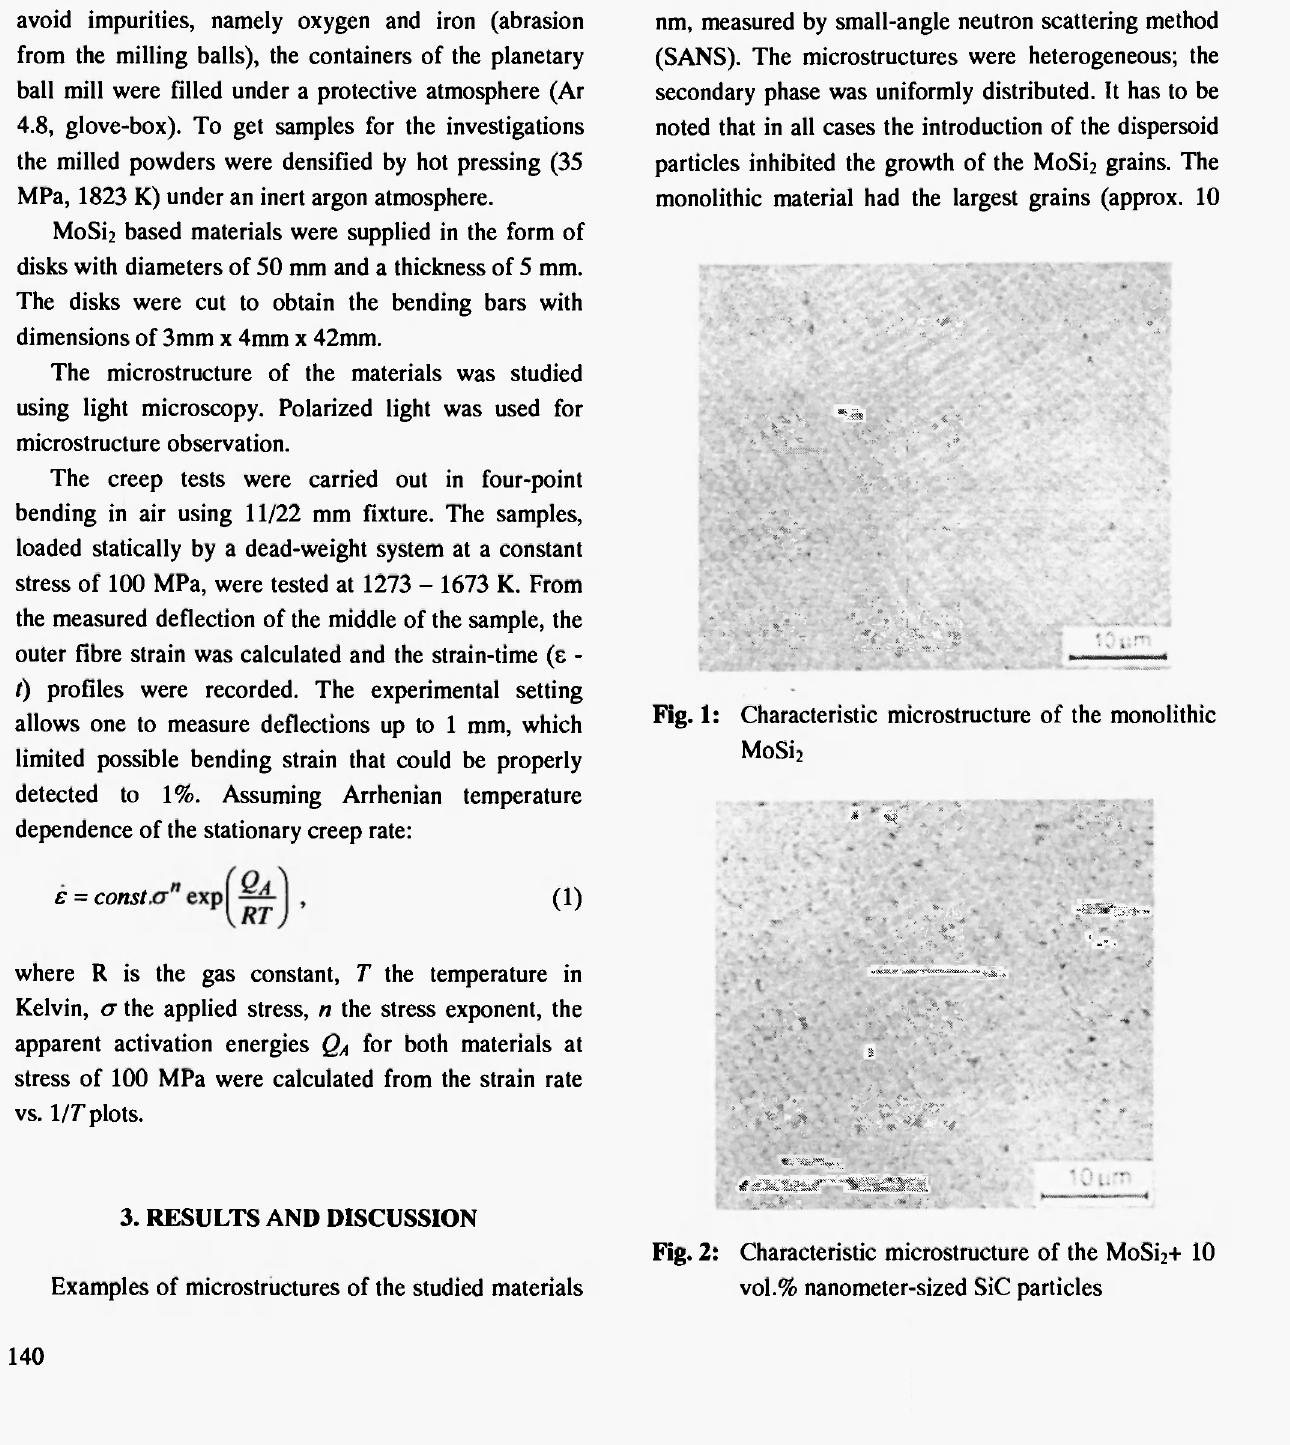
Fig. 1: Characteristic microstructure of the monolithic MoSi 2